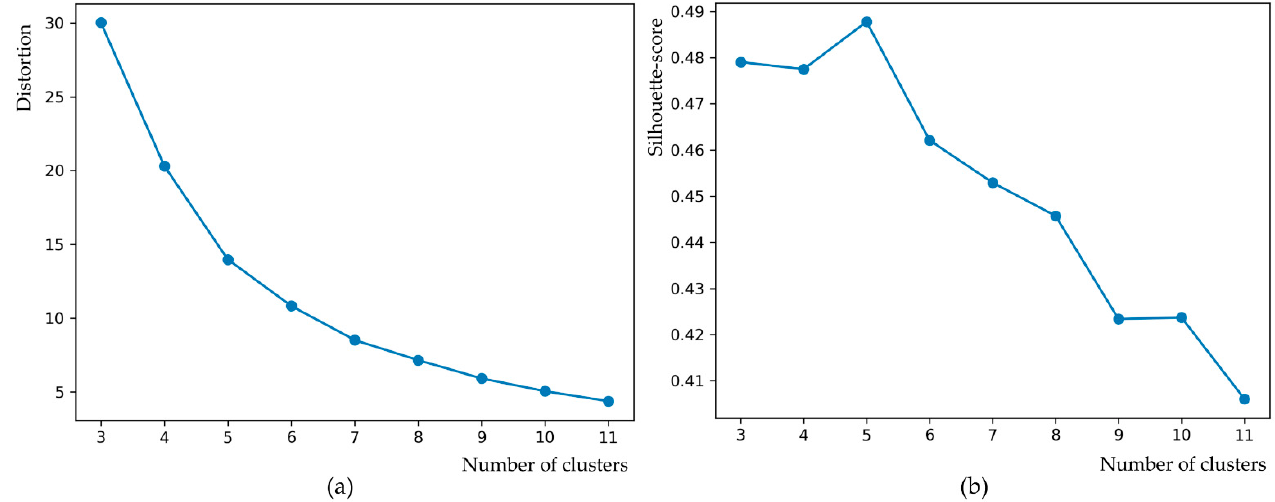
Figure 8. Determination of K value in clustering: ( a ) elbow method; ( b ) silhouette coefficient method.